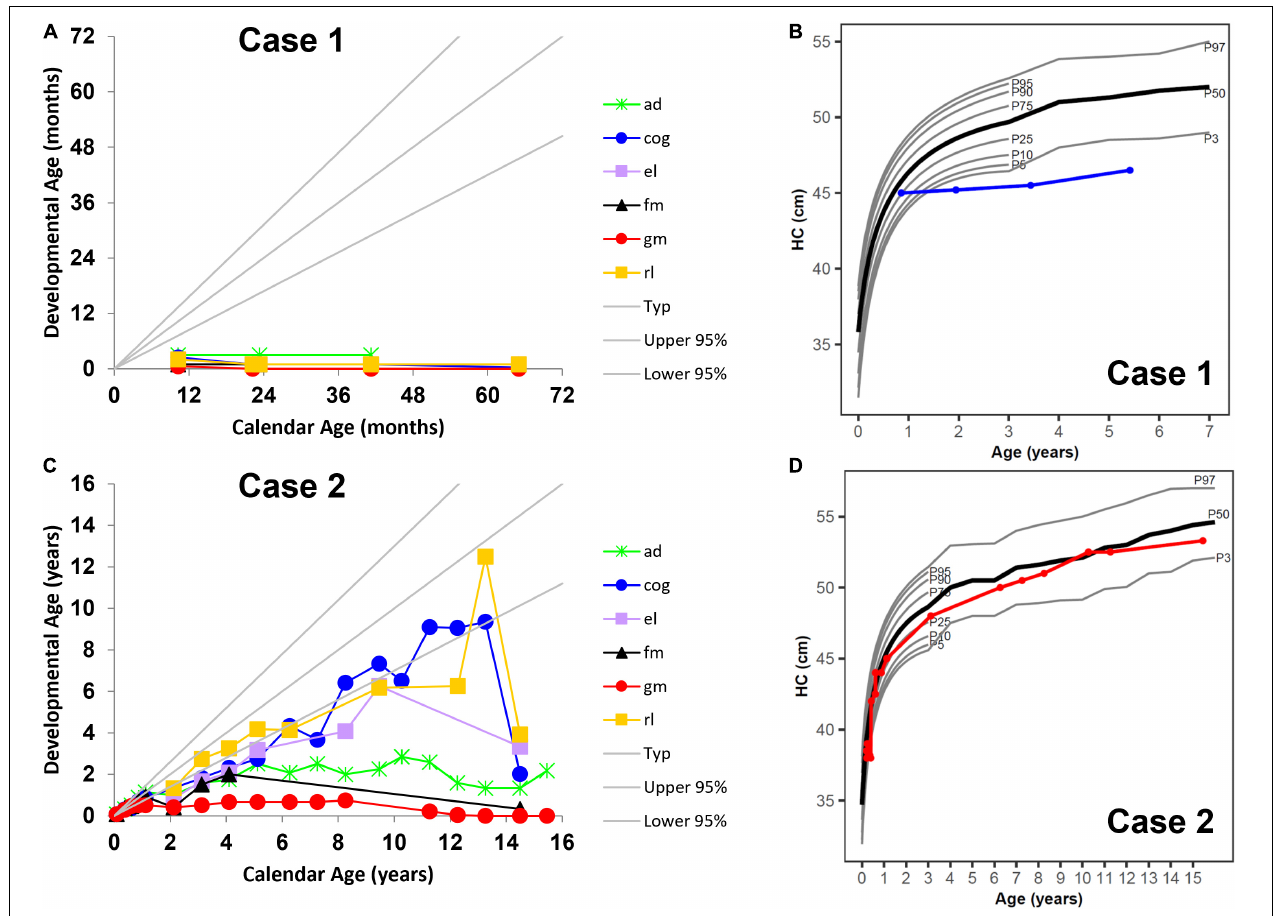
FIGURE 1 | Neurocognitive development across multiple domains (A) without umbilical cord blood transplantation (UCBT) (case 1) and (C) after UCBT (case 2) using age-equivalent scores (i.e., developmental age). Head circumference (HC) development (B) without UCBT (case 1) and (D) after UCBT (case 2). The colored lines in panels (A,C) represent individual domains. The colored lines in panels (B,D) represent case 1 (blue) and case 2 (red). In all panels, the area between the gray lines represents typical development. ad, adaptive behavior; cog, cognitive; el, expressive language; fm, fine motor; gm, gross motor; rl, receptive language. P3, P5, P10, P25, P50, P75, P90, P95, and P97 represent percentiles